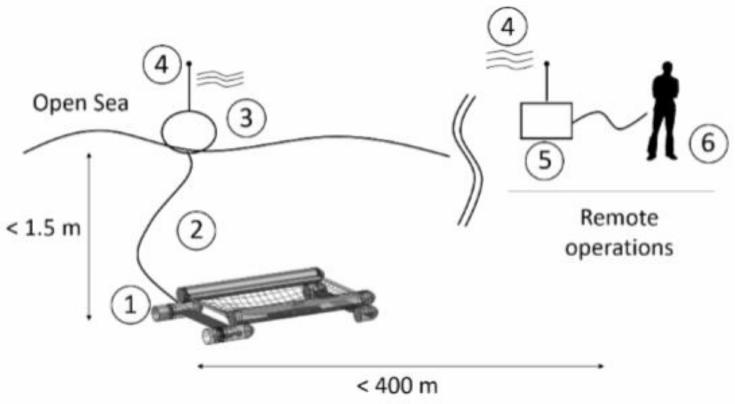
Figure 6. Buoyant communication system. 1: On board underwater transceiver. 2: Data cable. 3: Buoy. 4: Antenna. 5: Remote operations transceiver. 6: Remote